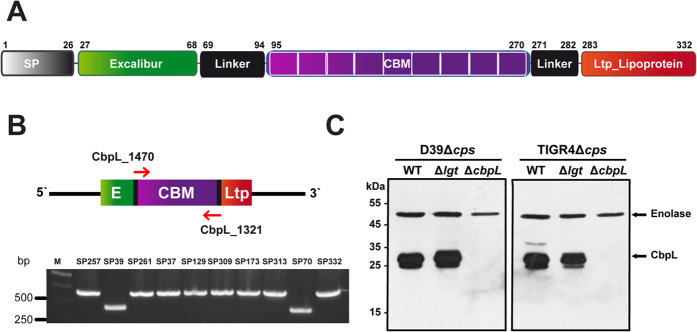
Expression of CbpL by pneumococci.(A) Modular organization of CbpL. (B) Molecular analysis of the variable numbers of choline-binding repeats in CbpL. A PCR using primers cbpL_1470 and cbpL_1321 was carried out using chromosomal DNA from various pneumococci as DNA template (Table S1) to amplify the cbpL gene. The length of PCR products was approximately 660 bp and 460 bp, respectively. Primer CbpL_1470 starts downstream of the Excalibur module and the reverse primer CbpL_1321 starts in the 3′end of the CBM module. (C) Immunoblot analysis of CbpL expression in wild-type, lgt- and cbpL-mutant pneumococci using specific polyclonal anti-CbpL antibodies. Enolase was used as a control.